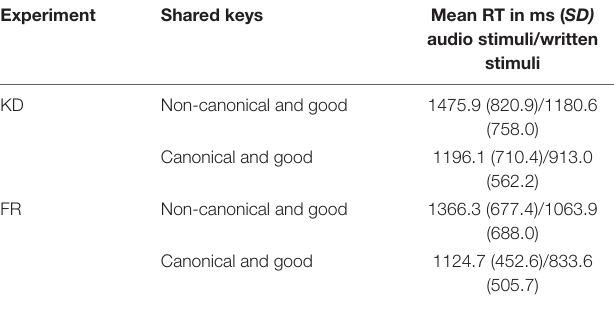
TABLE 4 | Participants’ mean reaction times (RT) and standard deviations (SD) separated by experiment condition (KD and FR), shared keys (congruent and incongruent to our hypothesis) and stimulus type (audio and